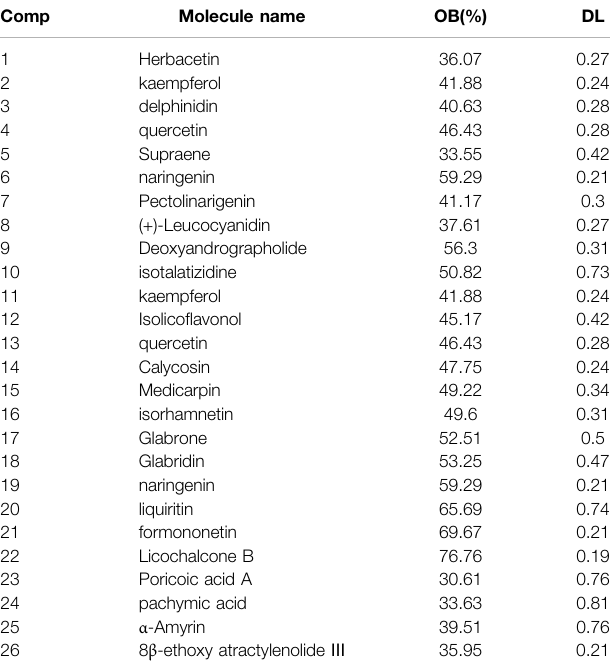
TABLE 2 | Compounds in MFSD with oral bioavailability (OB) larger than 30% and drug-likeness (DL) larger than 0.18, which combined with the results of ultra- performance liquid chromatography-mass spectrometry